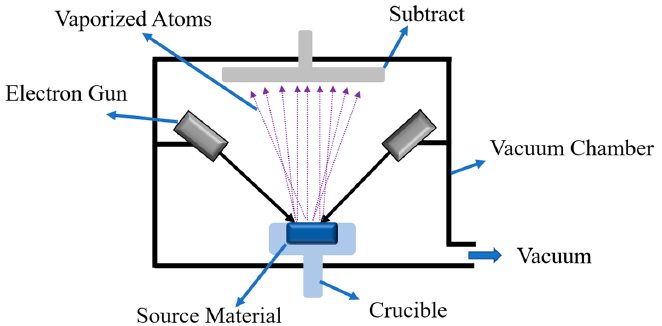
Figure 1. Schematic view of a physical vapor deposition (PVD) machine using electron beam as the heat source.